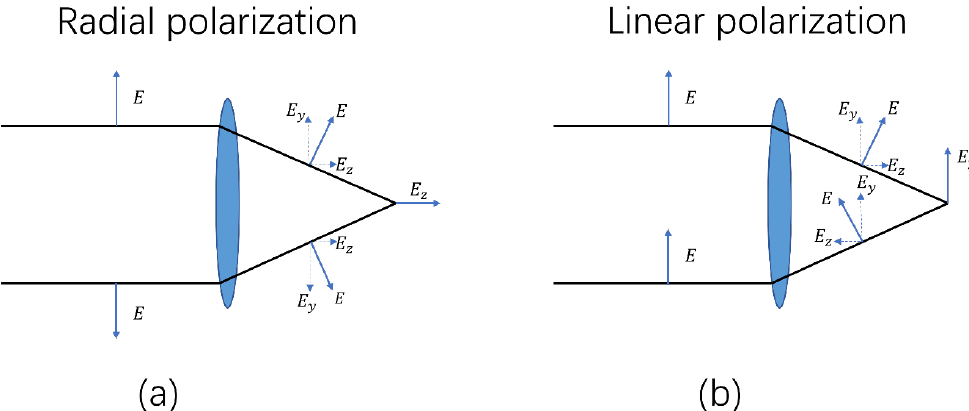
Figure 1. The directions of the electric fields at the focal plane originating from ( a ) radially polarized THz waves, and ( b ) linearly polarized THz waves.